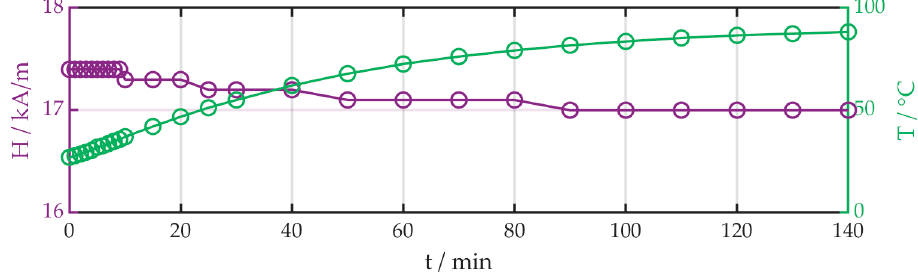
Figure 6. Temperature magnetic field diagram of the coil.